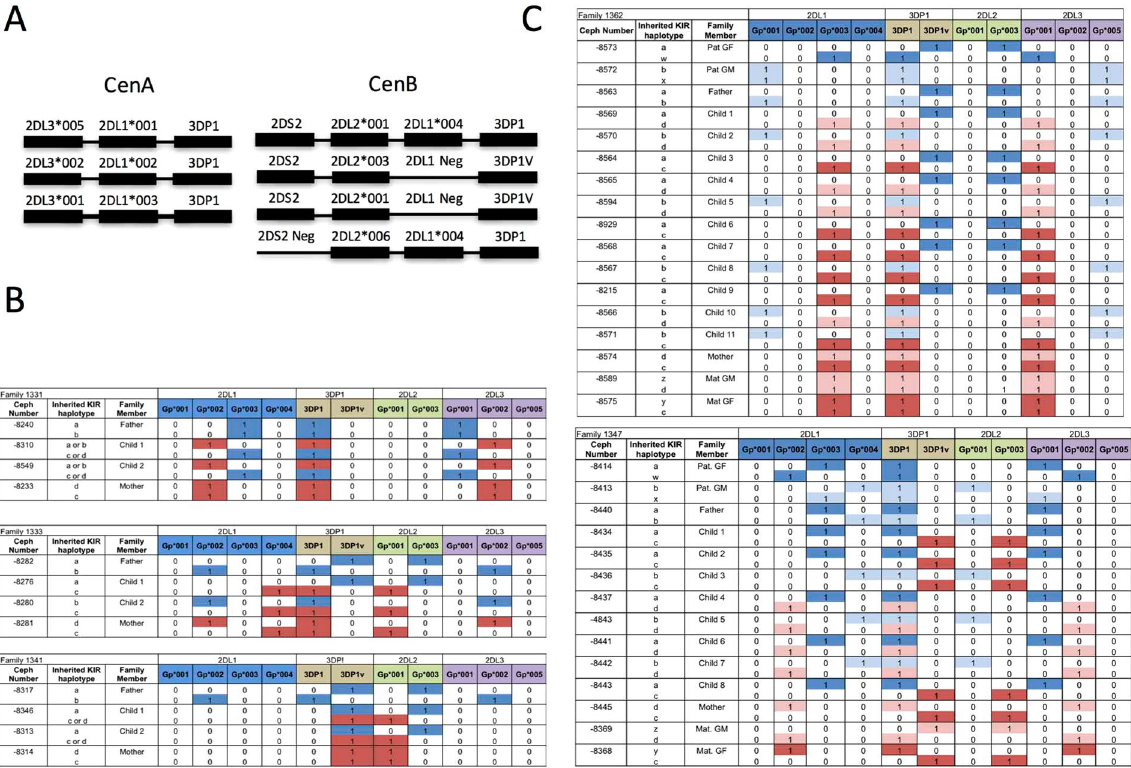
Figure 4. Linkage disequilibrium between KIR2DL alleles. ( A ) Linkage disequilibrium analysis identifies seven common combinations of centromeric KIR2DL alleles in a cohort of 260 individuals. ( B ) Allelic segregation of the KIR2DL and KIR3DP1 alleles in CEPH families. Paternal KIR2DL alleles are shown in blue; maternal alleles in red. ( C ) KIR2DL allele typing from three generations of CEPH family individuals demonstrates Mendelian inheritance of allele combinations established by the LD